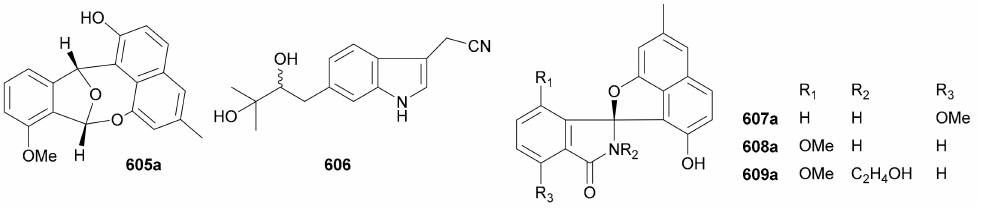
Figure 32. Structures of metabolites from